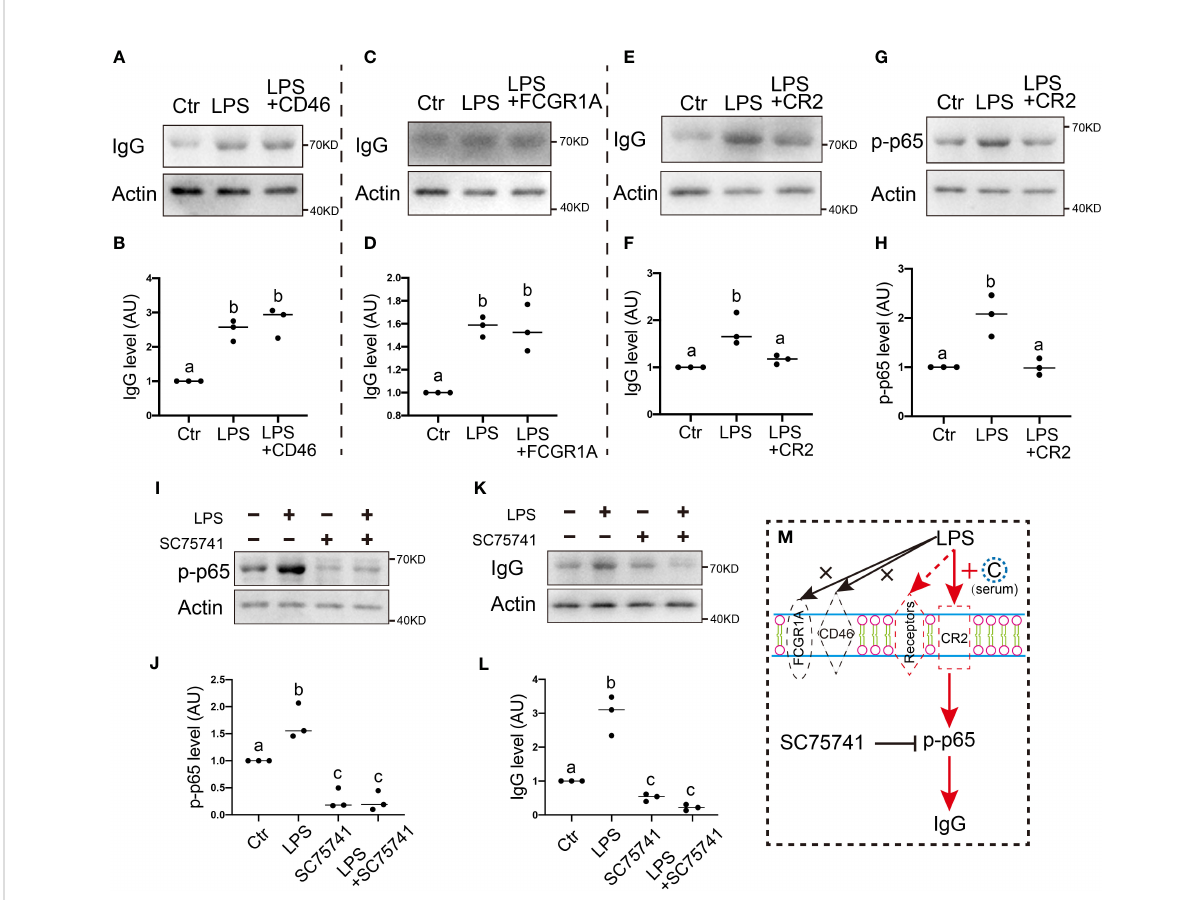
FIGURE 3 . Membrane receptor CR2 mediates IgG production in response to environmental LPS (A, B) Western blot and quanti fi cation show that on exposure to LPS stimuli, IgG levels signi fi cantly increased about one-fold, and CD46 (CD46 antigen, complement regulatory protein) blockage with the anti-CD46 antibody had no impact on the LPS-induced IgG increment. (C, D) Western blot and quanti fi cation show that FCGR1A (Fc fragment of IgG receptor Ia) blockage with anti-FCGR1A antibody had no impact on the LPS-induced IgG increment. (E-H) Western blot and quanti fi cation show that CR2 (complement receptor 2) blockage with anti-CR2 antibody brought the LPS-induced IgG increment back to the control level (E, F) CR2 blockage also brought LPS-induced p-p65 increment back to the control level (G, H) . (I-L) Western blot and quanti fi cation show that on exposure to LPS stimuli, both p-p65 and IgG level signi fi cantly increased about one-fold, and the NFKB inhibitor SC75741 brought the LPS-induced p-p65 or IgG increment back to the control level. (M) Model hypothesis for A-L. LPS-induced increment of p-p65 ! IgG is mediated by membrane receptor CR2, not CD46 or FCGR1A. Actin was used as a loading control. Difference lower-case letters indicate signi fi cant difference between two